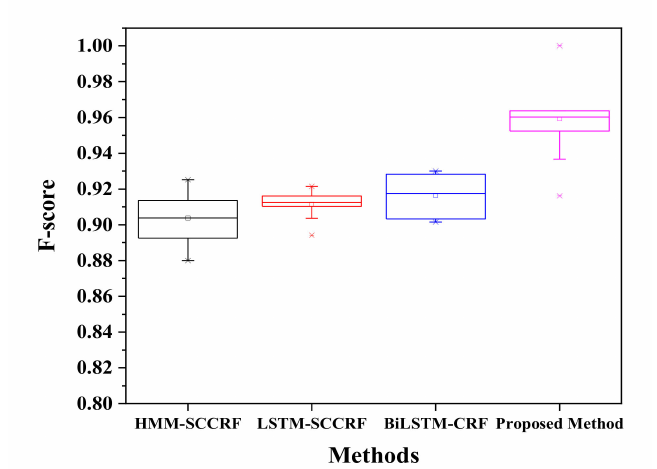
Figure 13. F-score comparison on